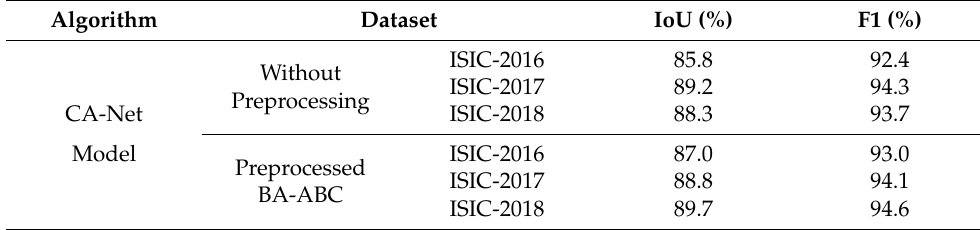
Table 5. Performance matrix comparison with CA-Net